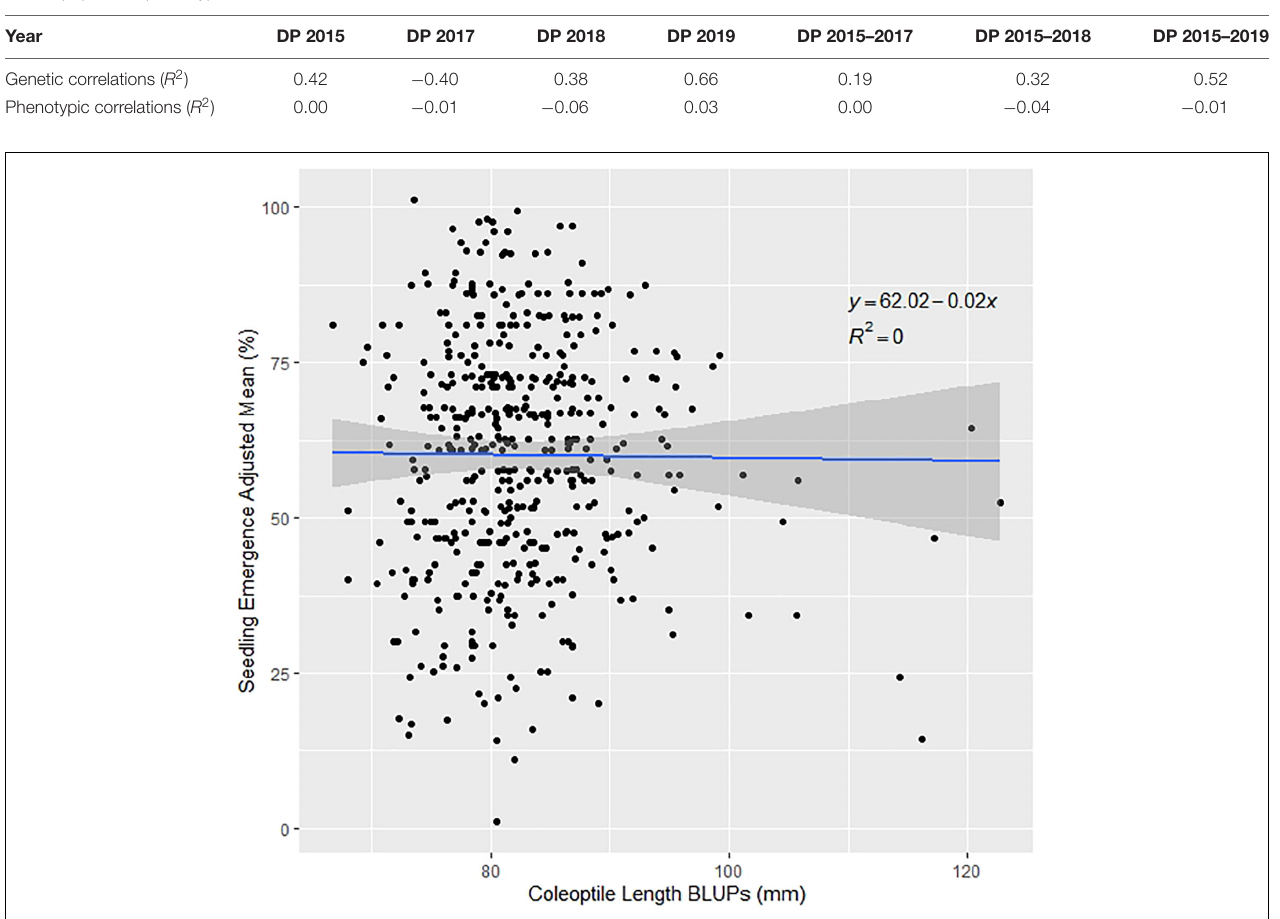
the DP and BLs, respectively. Significant markers were found on 19 of the 21 chromosomes in the DP, with the majority (34) of the significant markers located on chromosome 5A. In the BLs, 15